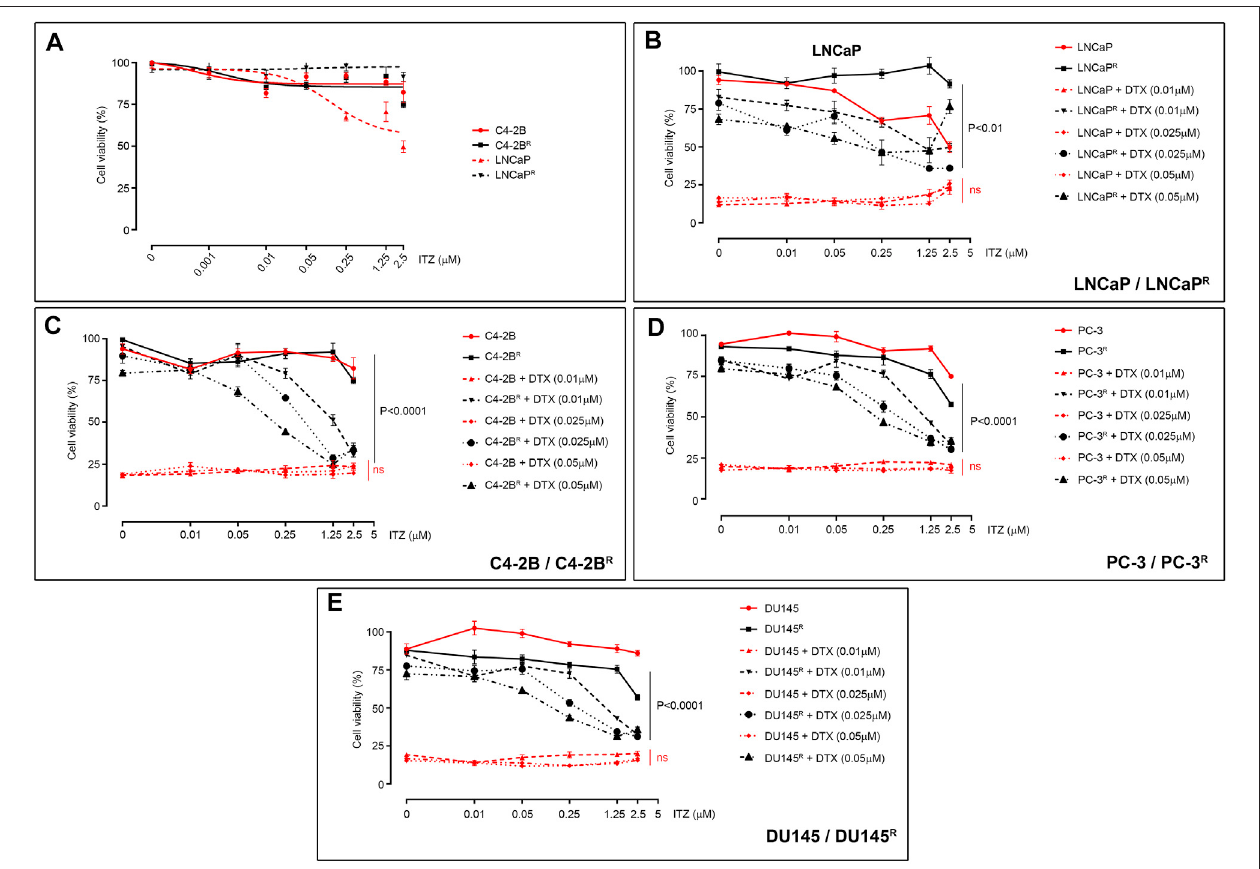
FIGURE 2 | Effect of ITZ on PCa cells. (A) Effect of ITZ on LNCaP, C4-2B, LNCaP R and C4-2B R cells, with only LNCaP showing dose-dependent cytotoxicity. Combining increasing concentrations of ITZ with DTX showed dose-dependent reversal of drug-resistance in DTX-resistant PCa cell lines (B) LNCaP R , (C) C4-2B R , (D) PC-3 R and (E) DU145 R . Cell viability was measured using a standard MTT assay, following exposure of cells to varying concentrations of docetaxel for 72 h. All plotted values are normalized to the untreated control. Signi fi cance in differences of best- fi t IC 50 values for the different ITZ + DTX combinations were tested by two-way ANOVA. ns: non-signi fi cant p